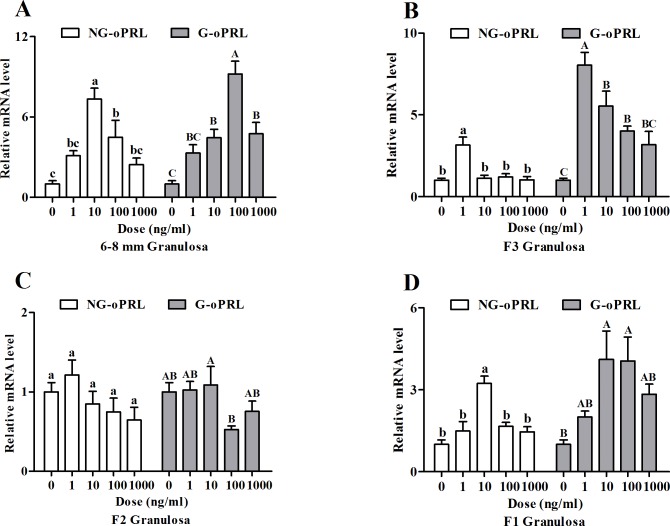
Regulation of PRLR transcript by non-glycosylated (NG-) and glycosylated (G-) ovine PRL (oPRL) (0, 1, 10, 100 or 1000 ng/ml) in cultured granulosa cells of the 6–8 mm (A), F3 (B), F2 (C) and F1 (D) follicles after a 24-h culture. Relative expression level was normalized to 18S rRNA. Data are expressed as fold differences ± SEM of three independent experiments using tissues from different hens and are compared to control cells of each follicular class. Different letters indicate significant differences at P < 0.05.